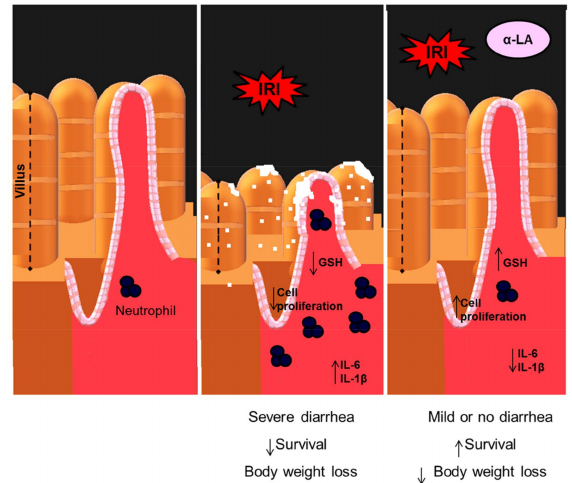
Figure 6. Proposed model of action of α -LA in the intestinal mucositis induced by irinotecan. Irinotecan (IRI) decreases the proliferation of intestinal crypt epithelial cells, promoting their breakdown and decreasing the intestinal villi. Abnormalities in these structures are potentiated by the decrease in GSH and the increase in IL-6 and IL-1 β , which subsequently recruit neutrophils resulting in severe diarrhea, body weight loss and reduction in survival. Whereas α -LA prevents these irinotecan-induced changes by increasing the proliferation of crypt epithelial cells and inhibiting the synthesis of IL-1 β and IL-6 resulting in the decrease in weight loss and the improvement in diarrhea and survival of animals with intestinal mucositis induced by